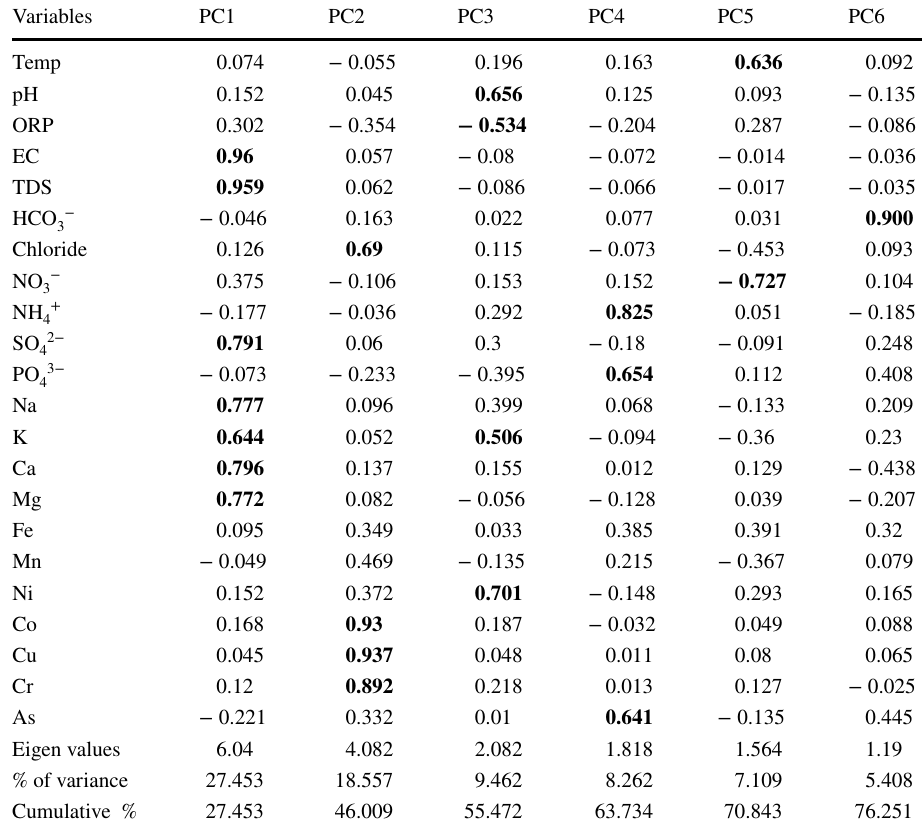
Table 5 PCA of groundwater characteristics in